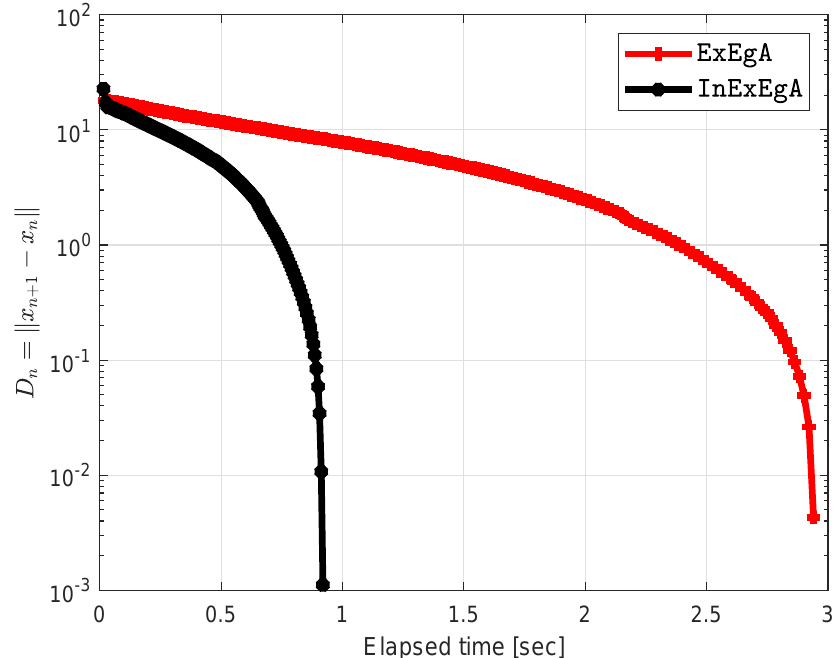
Figure 6. Algorithm 1 comparison with Algorithm 1 in [16] and elapsed time in seconds are 2.9404 and 0.9194 respectively.